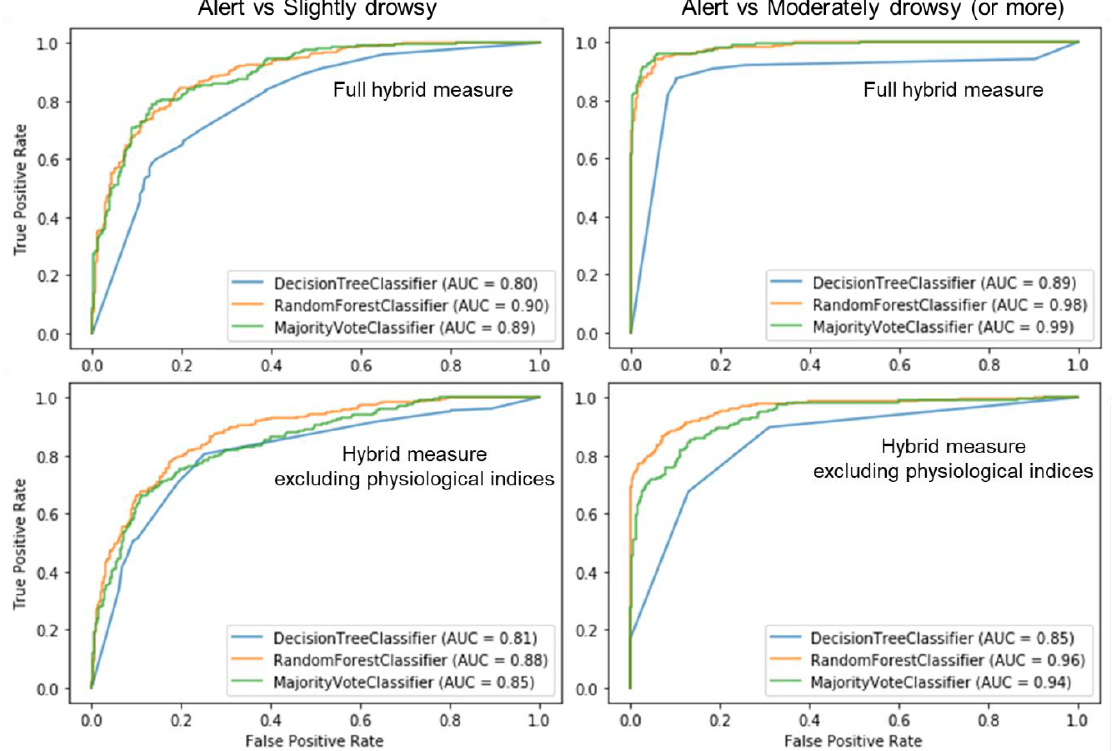
Figure 6. Receiver operating characteristic curves of the classification. Table 5. Priority of features in the case of using random forest algorithm (Top 10).